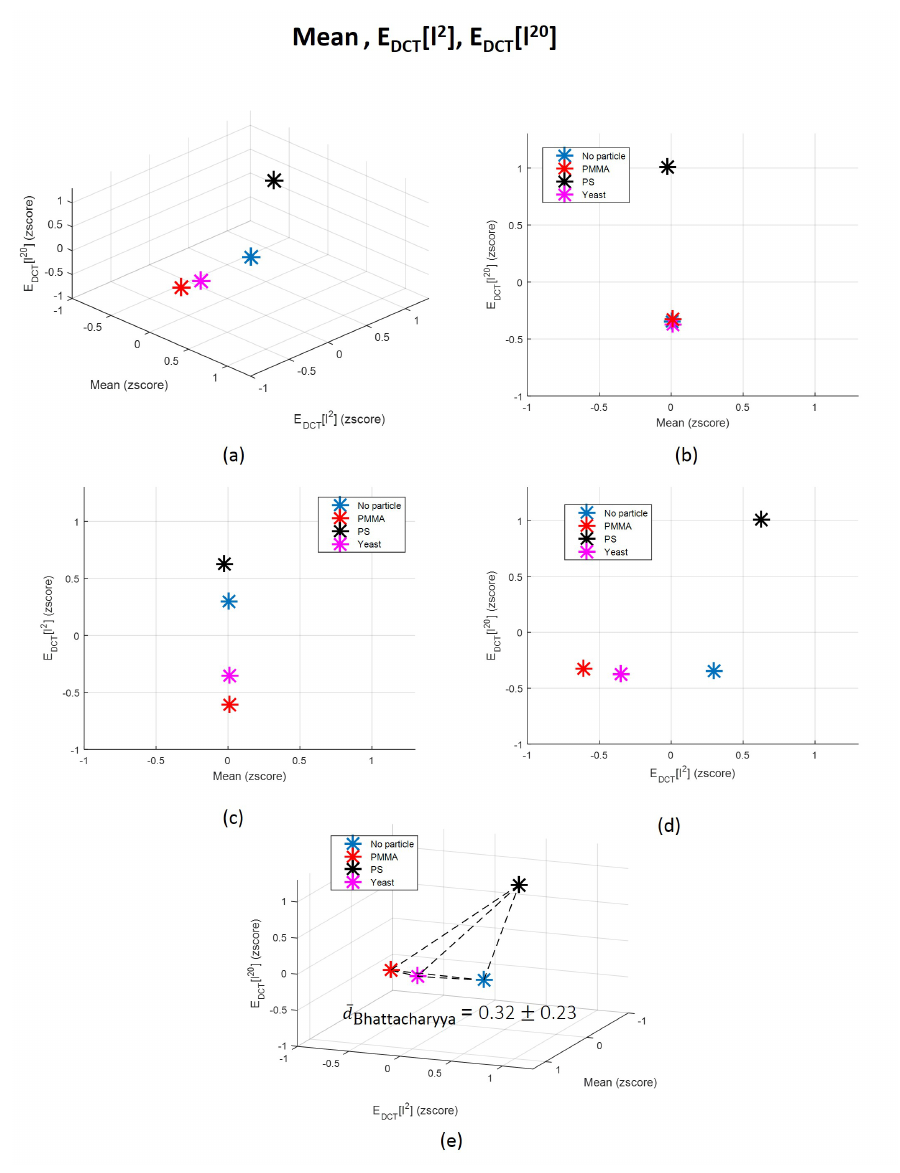
Figure 13. ( a ) 3-dimensional representation of the three original features ( Mean , E DCT [ l 2 ] and E DCT [ l 20 ] ) whose information contributed the less for the final LDA-derived one; ( b – d ) 2D decompositions of the 3D space; and ( e ) correspondent average Bhattacharyya distance between each pair of classes distributions and graphical representation of each distance norm. Each point represents the mean value in the 3D space corresponding to each class: “Class 1: No particle”, “Class 2: PMMA”, “Class 3: PS” = 0.32; d No particle / PS = 0.27; d No particle / Yeast = and “Class 4: Yeast”. d No particle / PMMA Bhattacharyya Bhattacharyya Bhattacharyya